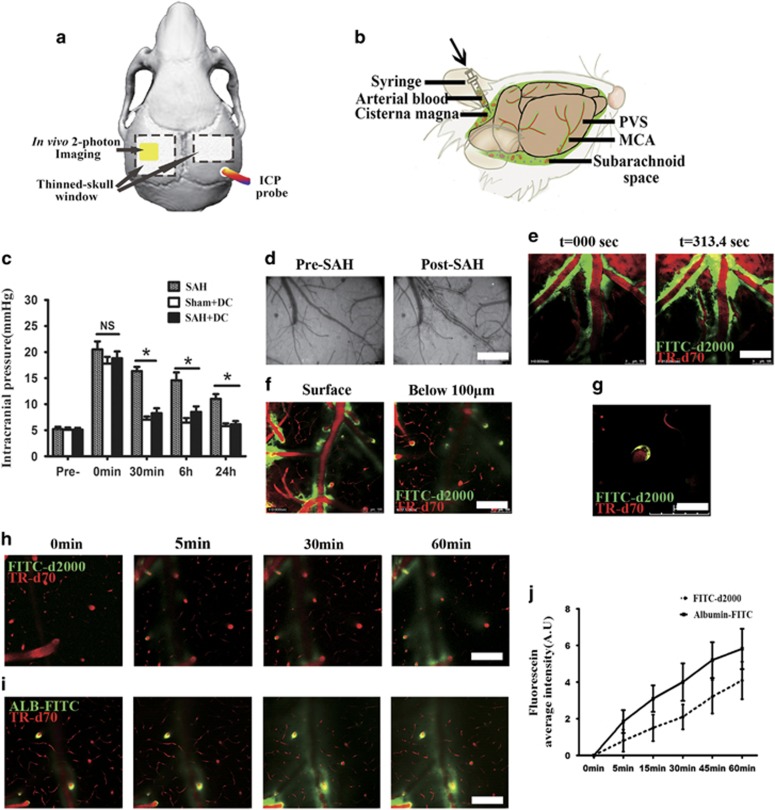
Subarachnoid blood flows into the brain parenchyma through the PVS after SAH in mice. (a) Schematic illustrating a decompresive thinned-skull window and ICP monitoring. (b) Schematic illustrating a SAH animal model established by injection of allogenic blood into cisterna magna. (c) Decompresive thinned-skull windows inhibited ICP elevation induced by intracisternal blood injection (n=5). (d) Representative images showing the appearance of the PVS surrounding the pia artery after SAH by a camera. (e) Representative images showing subarachnoid blood (labeled by FITC-d2000) flows into the PVS surrounding the pial artery (the bloodstream is defined by intravenously injected TR-d70) after SAH with two-photon imaging. (f) Representative images scanned at 100 μm below the brain surface showing subarachnoid blood flows into the PVS surrounding penetrating arterioles (the bloodstream is defined by intravenously injected TR-d70). (g) Representative images showing the presence of a blood cell in the PVS of penetrating arterioles. (h) Representative images recorded the movement of FITC-d2000-labeled blood into the perivascular parenchyma along the penetrating arteriole over time. (i) Representative images recorded the movement of albumin (67 kDa) labeled with FITC (ALB-FITC) into the perivascular parenchyma along the penetrating arteriole over time. (j) The movement of ALB-FITC into the brain parenchyma was much faster compared with that of the FITC-d2000-labeled blood after the intracisternal injection (n=3). Scale bar: 60 μm. Abbreviation: MCA, middle cerebral artery